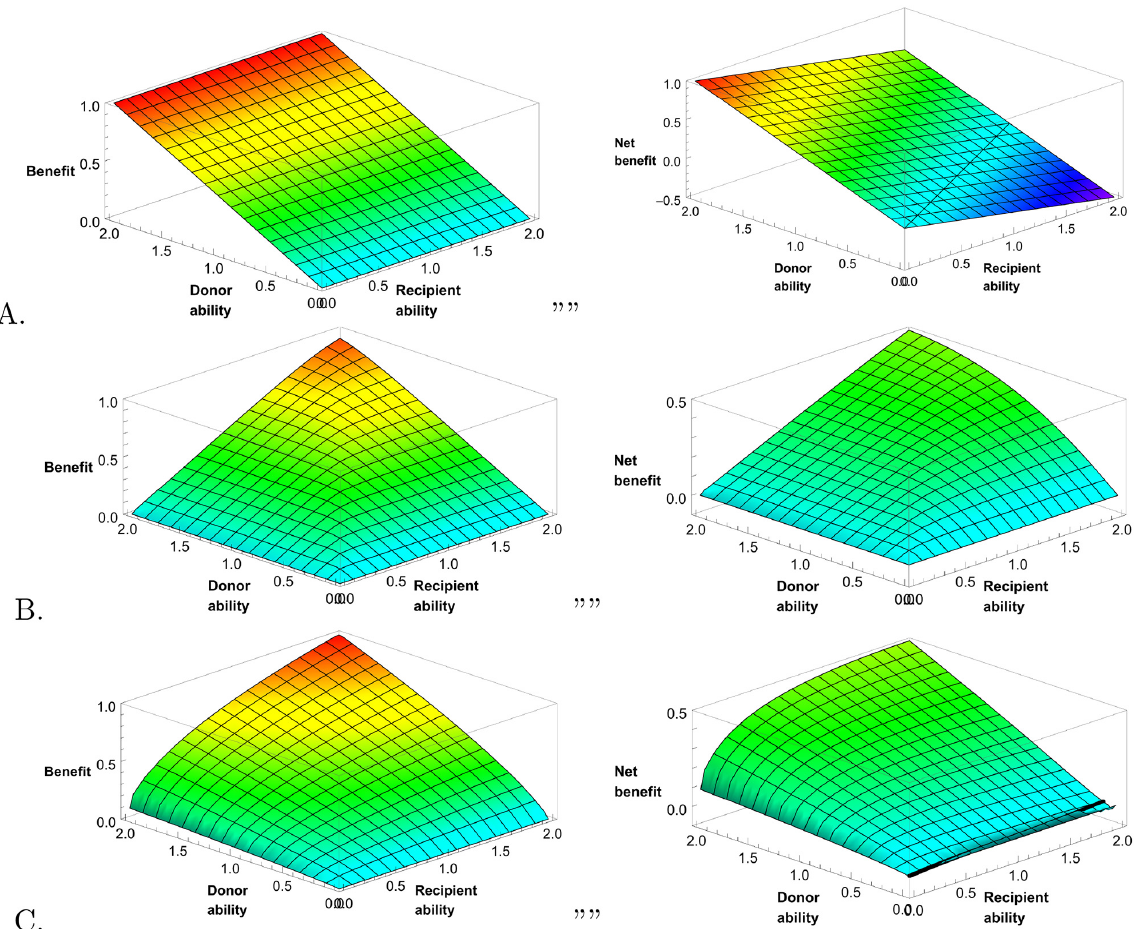
Fig 1. Three distributional norms. How benefits should be distributed as a function of recipient ( x ) and donor ( y ) ability, according to norms of (A) Pure Altruism, (B) Almost Balanced Reciprocity, and (C) Generalized Reciprocity. On left, benefits, b [ x , y ]; on right, recipient net benefits, b [ x , y ] − c [ x , y ]. Colors scale with benefits or net benefits, 1.0 is red, 0.0 is light blue. Black lines show where net benefits equal